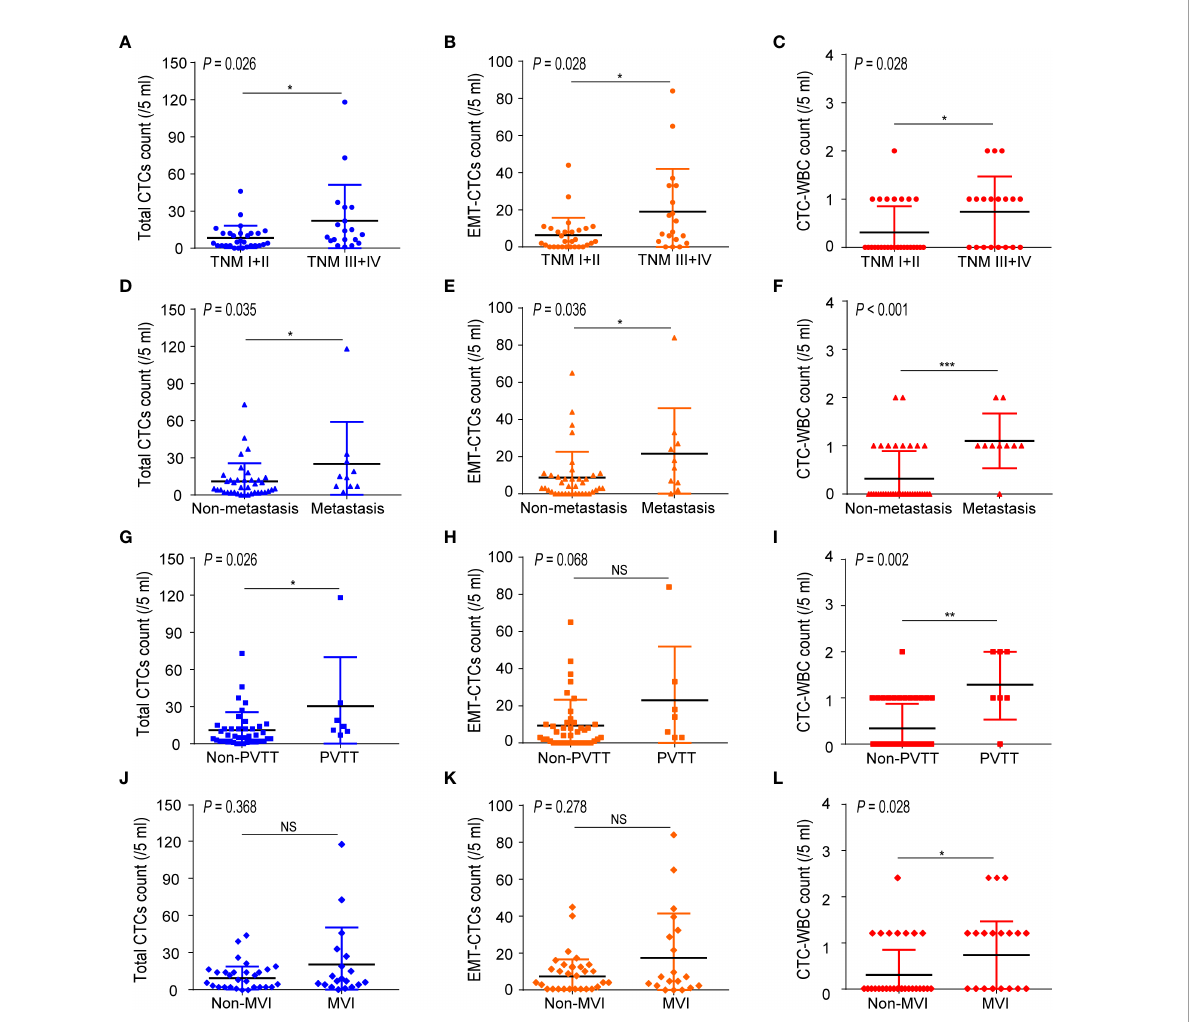
FIGURE 2 Correlations between the number of CTC parameters (total CTCs, EMT-CTCs, and CTC-WBC cluster) and clinicopathological characteristics of the pre-treated HCC patients. (A – C) Comparison of the CTCs parameters between TNM I + II and TNM III + IV groups. (D – F) Comparison of the CTCs parameters between non-metastasis and metastasis groups. (G-I) Comparison of the CTCs parameters between non-PVTT and PVTT groups. (J – L) Comparison of the CTCs parameters between non-MVI and MVI groups. * P < 0.05, ** P < 0.01, *** P < 0.001 and NS means not signi fi